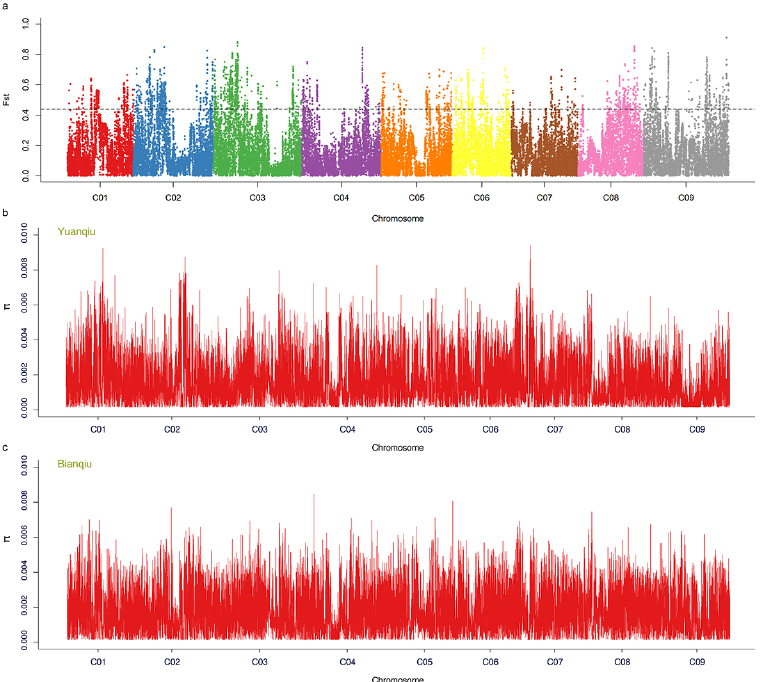
Figure 3. Fst and θπ analysis of two kinds of leaf ball shape B. oleracea accessions using SNPs. ( a ) Fst distribution map. The x -axis represents different chromosome names, the y -axis represents the Fst value in the corresponding windows of each chromosome, and the dotted line represents the selection threshold (top 5%). ( b ) Selective sweep analysis of “Yuanqiu” using θπ . The x -axis represents the chromosome position, and the y -axis represents the nucleotide polymorphism level. ( c ) Selective sweep analysis of “Bianqiu” using θπ